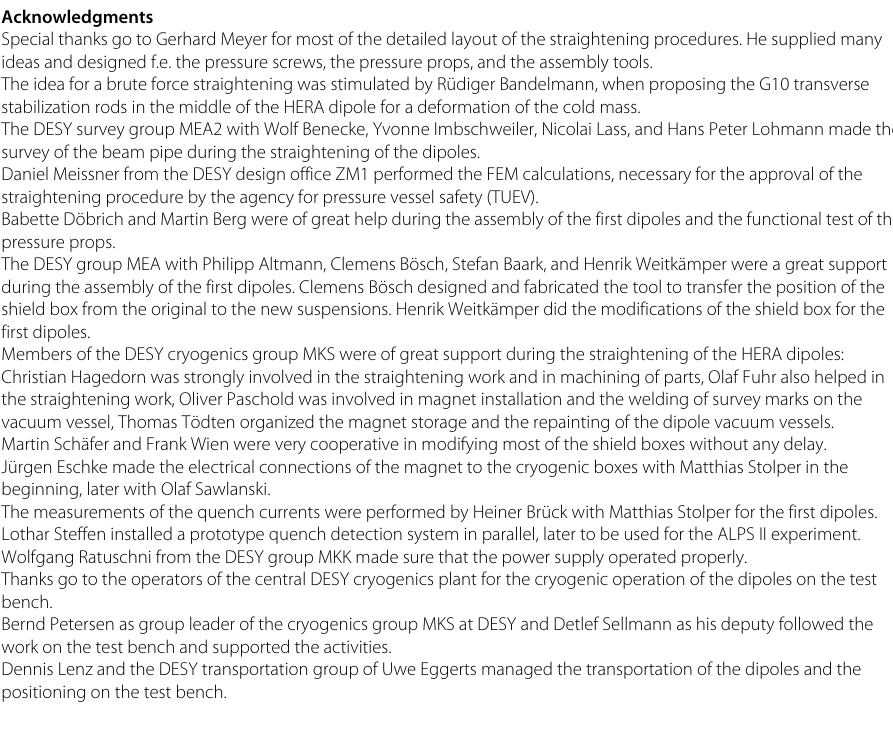
aperture near the middle of the experiment, following the envelope of the photon beam in the optical resonators. There is about ± 2mm free space for adjustment uncertainties, without limiting the performance of the optical